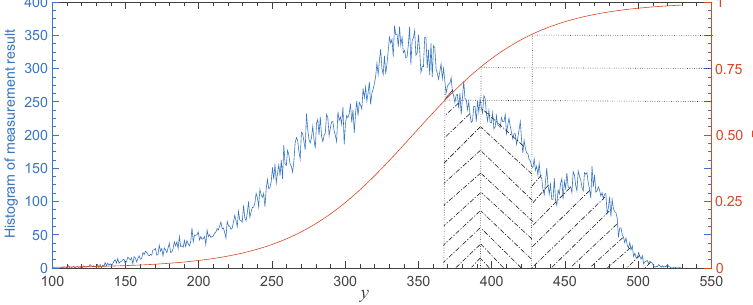
Figure 4. The process of